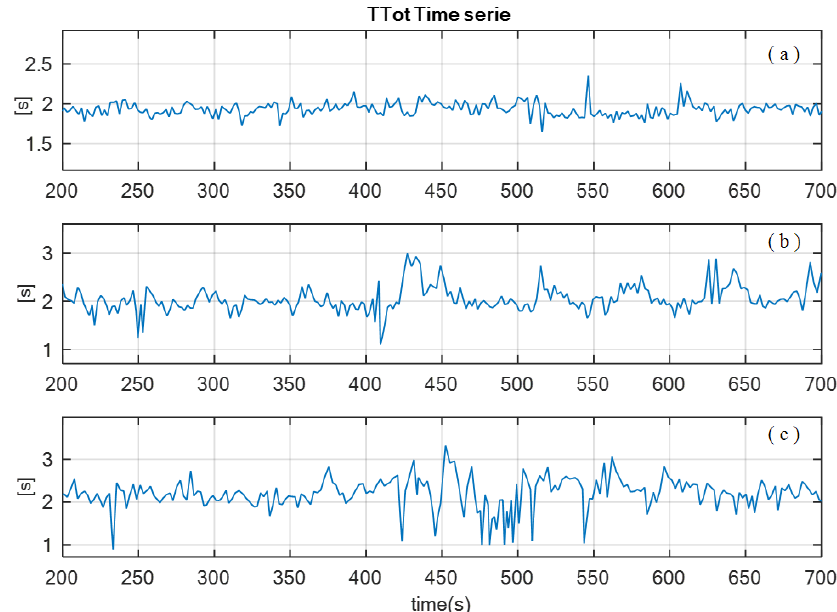
Figure 2. Excerpt of breathing duration time series ( 𝑇 𝑇𝑜𝑡 ) of a patient from ( a ) successful group (SG), ( b ) failed group (FG), and ( c ) reintubated group (RG).